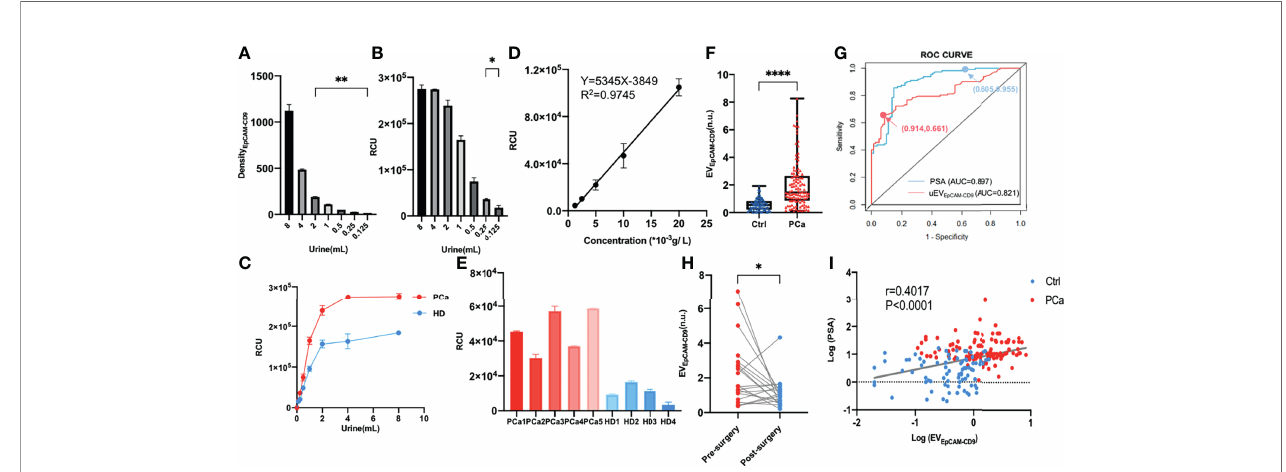
FIGURE 3 | Urinary EpCAM-CD9-positive EV is a potential biomarker for PCa diagnosis. (A) The uEV EpCAM-CD9 in different urine volumes was detected by WB. (B) The uEV EpCAM-CD9 from different urine volumes was detected by our chemiluminescent immunoassay. (C) The uEV EpCAM-CD9 of the pooled samples from PCa and healthy controls were detected by EV assay. (D) A standard curve was for urinary EV quanti fi cation using our EV assay. (E) The uEV EpCAM-CD9 from nine randomly selected donors including fi ve PCa and four HDs was assayed by the chemiluminescent immunoassay. (F) The levels of uEV EpCAM-CD9 was observed from men with PCa (n = 112) and without PCa (n = 81). (G) The ROC curve of uEV EpCAM-CD9 and PSA. (H) The uEV EpCAM-CD9 was detected before and after prostatectomy in 20 PCa patients. (I) The correlation between the uEV EpCAM-CD9 and PSA. Density EpCAM-CD9 , EpCAM-CD9 protein density; RCU, relative chemiluminescent unit; EV EpCAM-CD9 , EpCAM-CD9-positive extracellular vesicles; Ctrl, control; PCa, prostate cancer; ROC, receiver operating characteristic; uEVEpCAM-CD9, urinary EpCAM-CD9-positive extracellular vesicles; PSA, prostate-speci fi c antigen; AUC, area under the curve; HD, healthy donor. *P < 0.05,**P < 0.01,****P <